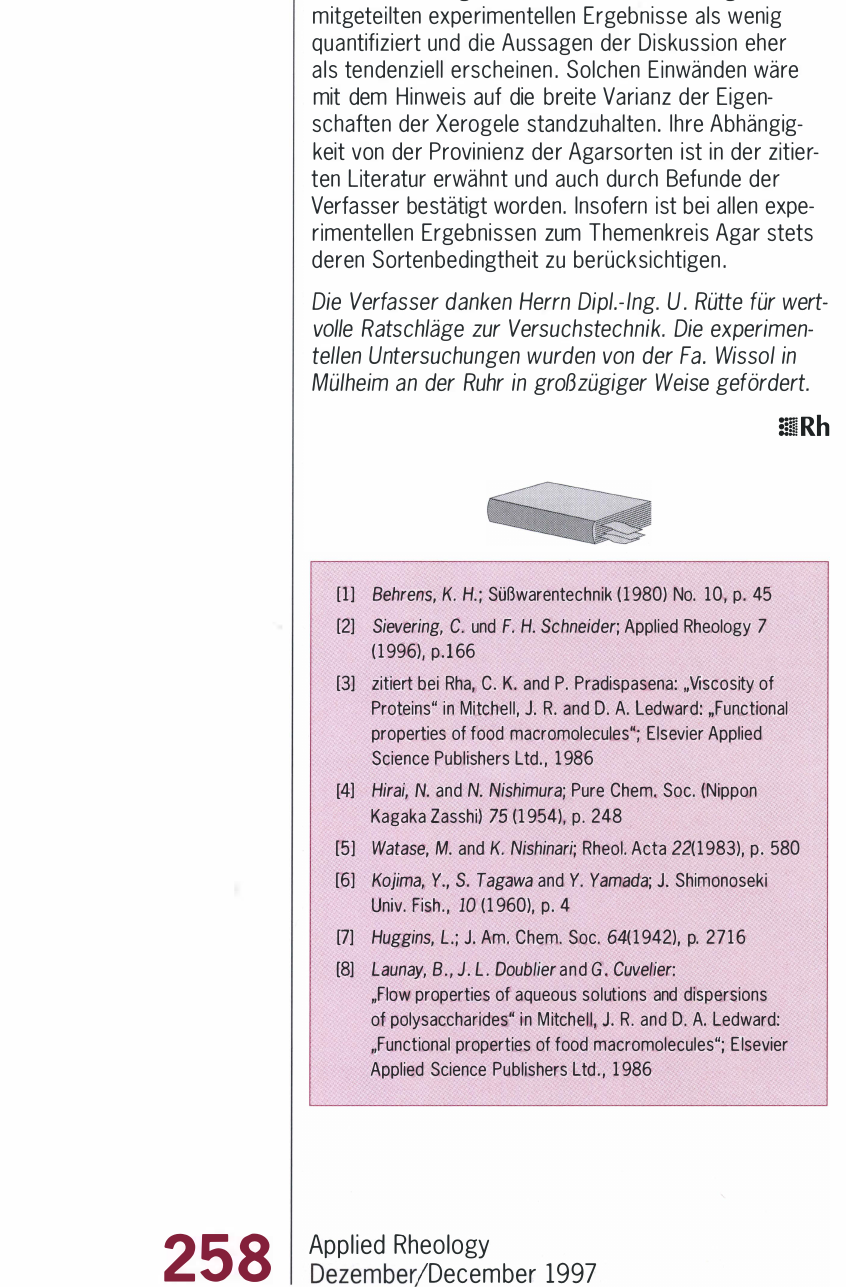
Spezifisches Knauelvolumen statistischer Kniiuel Specific coil volume of statistical